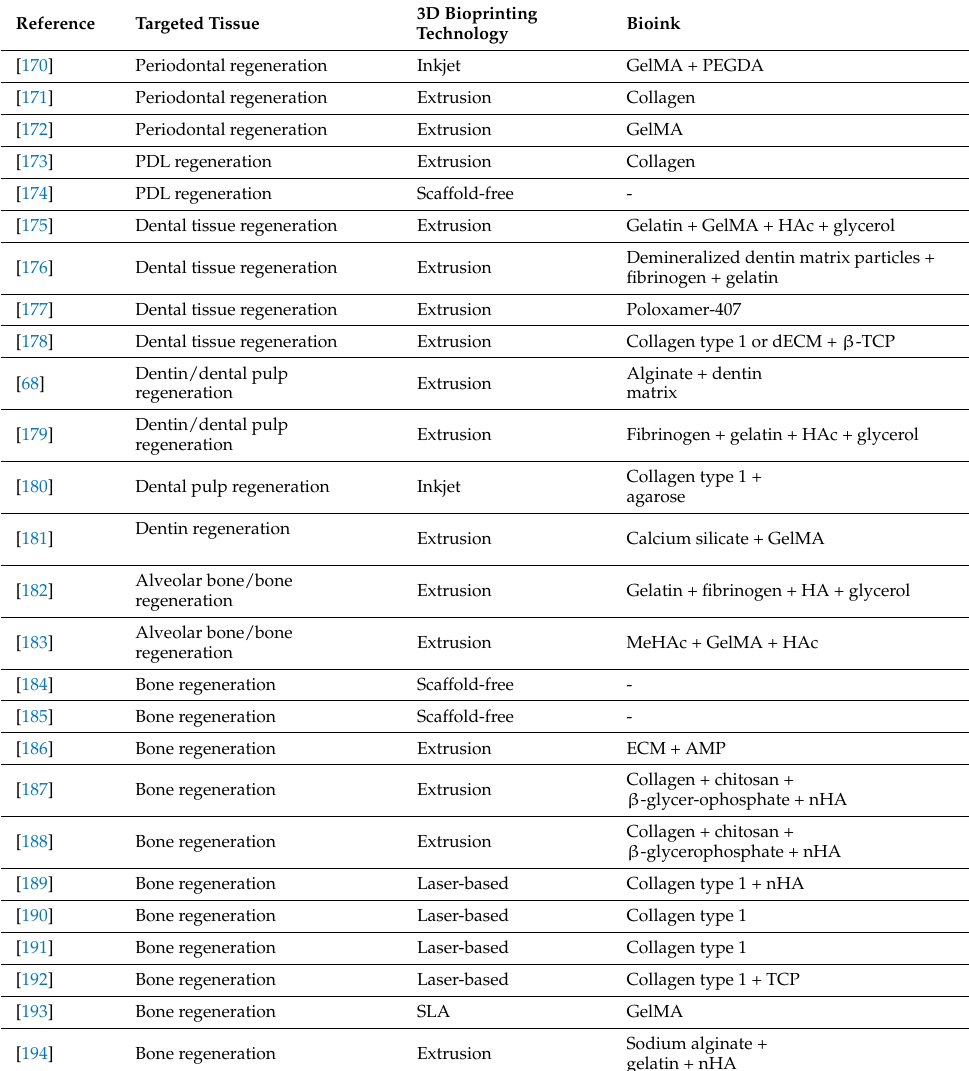
Table 2. 3D bioprinting applications in dentistry and maxillofacial surgery.